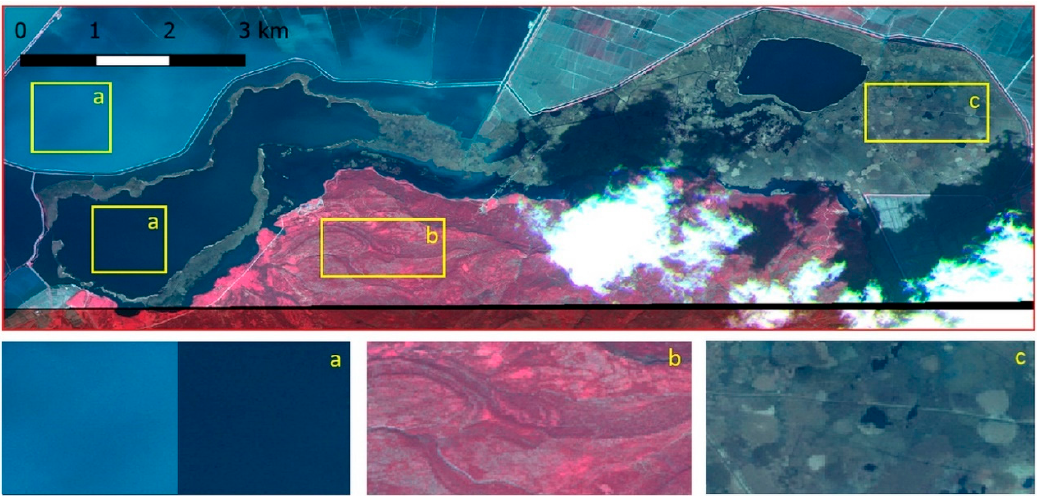
Figure 3. High-resolution false-color (NIR, green, blue) RapidEye image (April 04, 2015). (© Planet Labs Inc.) for southern Greece/Turkey containing TOW ( a ), DL ( b ), and TFV ( c ).